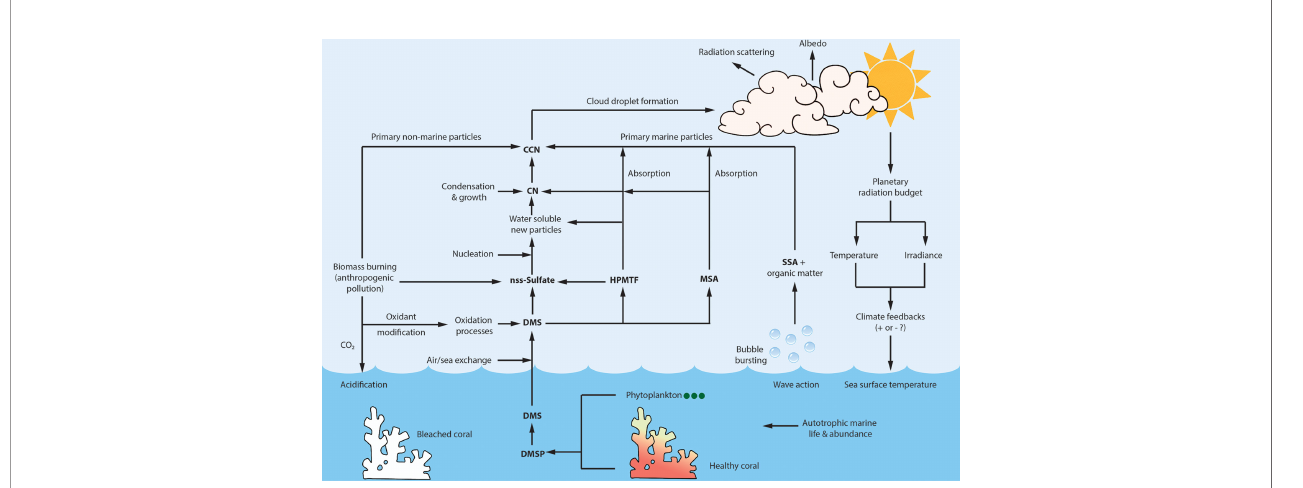
FIGURE 1 | Schematic of the proposed climate feedback loop according to the CLAW hypothesis (Charlson et al., 1987) adapted to the GBR with some updated information. DMSP, produced by coral and phytoplankton, is the dominant source of DMS which on exchange to the atmosphere can be oxidized to products such as nss-SO 4 and HPMTF which are involved in new particle production, while MSA primarily contributes to the growth of existing particles. CCN formed from these DMS oxidation products can generate marine clouds with increased albedo, which may alter the Earth ’ s radiation budget leading to the hypothesized climatic feedback. The proposed biogenic feedback loop may be perturbed by primary marine sources of CCN such as SSA and organic matter released from surface waters by bubble bursting. Anthropogenic forcing over the GBR may contribute to recurrent coral bleaching and loss of DMS production to dampen the feedback loop. Additionally, regional biomass burning may contribute nss-sulfate and primary particles in the CCN size range (D p ~50-100 nm) (Zaveri et al., 2022) as well as terrestrially-derived oxidants that may alter the background marine atmospheric oxidation processing capacity (Mauldin III et al., 2012; Zhu et al., 2021). Condensation nuclei (CN), Cloud condensation nuclei (CCN), Dimethylsul fi de (DMS), Dimethylsulfoniopropionate (DMSP), Particle diameter (D p ), Great Barrier Reef (GBR), Hydroperoxymethyl thioformate (HPMTF), Methanesulfonic acid (MSA), non sea salt sulfate (nss-Sulfate), Sea spray aerosol